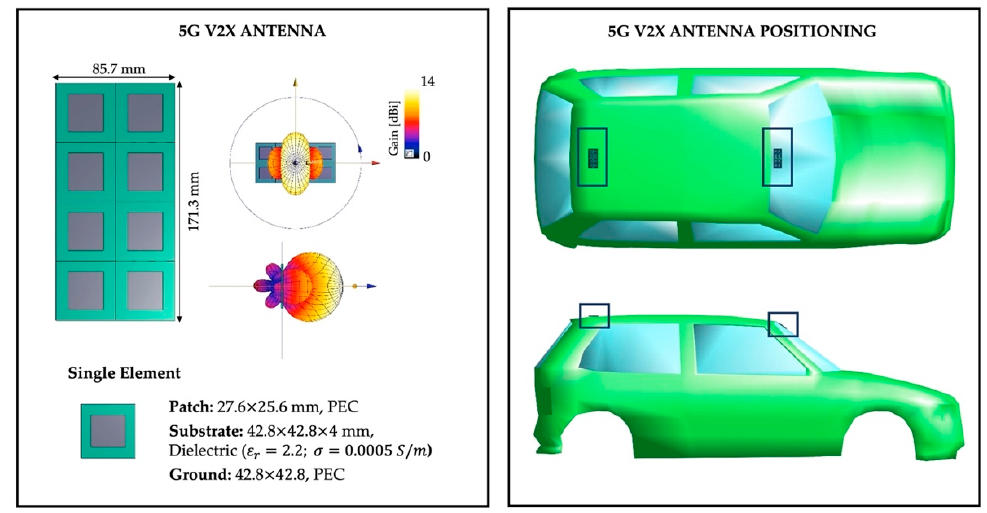
Figure 1. On the left, the characteristics and geometry of the 5G-V2X antenna. On the right, the positions of the two 5G-V2X antennas on the car.